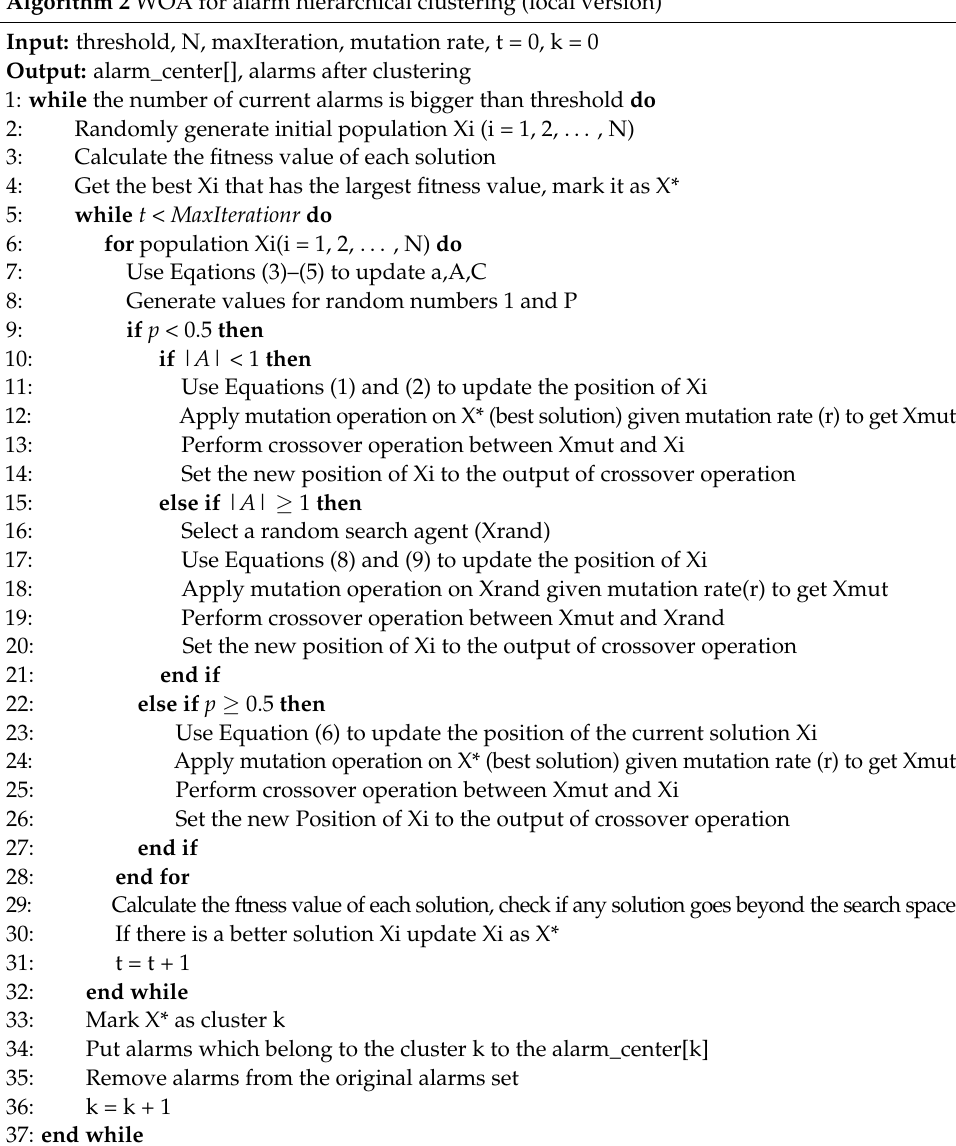
Algorithm 2 WOA for alarm hierarchical clustering (local